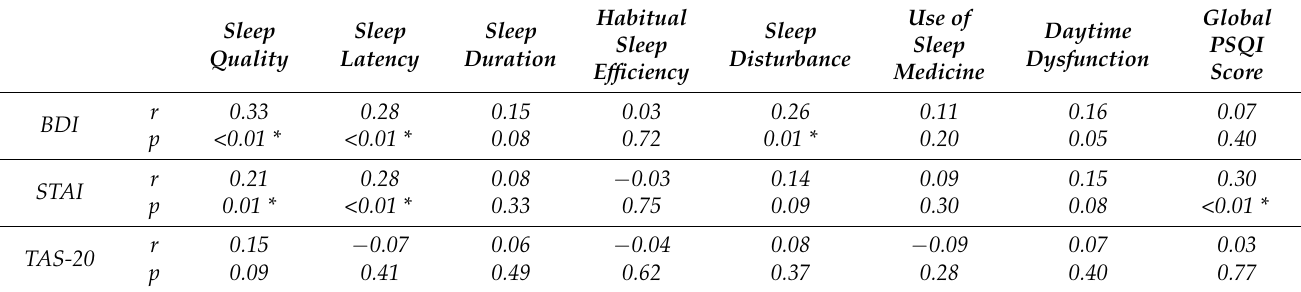
Table 5. Correlations between Pittsburgh Sleep Quality Index and psychological variables.